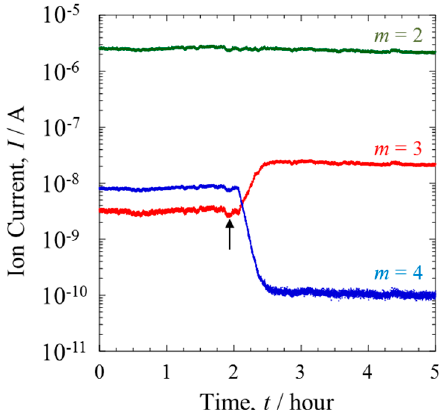
Figure 2. Transient behavior of Q-Mass spectra of mass numbers m = 2 (H 2 , green line), 3 (HD, red line) and 4 (D 2 , blue line) at the anode side. A mixture of H 2 (10.0 mL · min − 1 ) and D 2 (0.1 mL · min − 1 ) was passed through the PEFC for 2 h and then passed directly to the Q-Mass for 3 h without power generation.